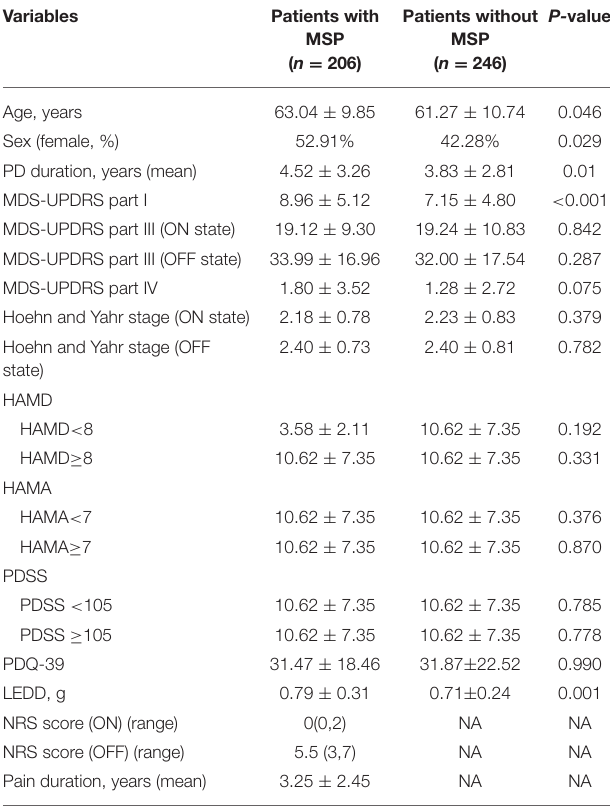
TABLE 1 | Demographics and clinical characteristics of the study population.